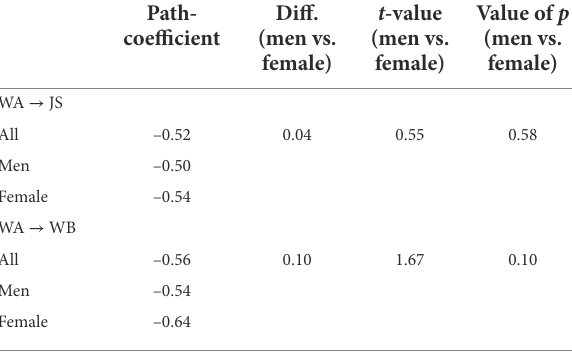
TABLE 3 Multi-group analysis (gender) in Path-coefficient.